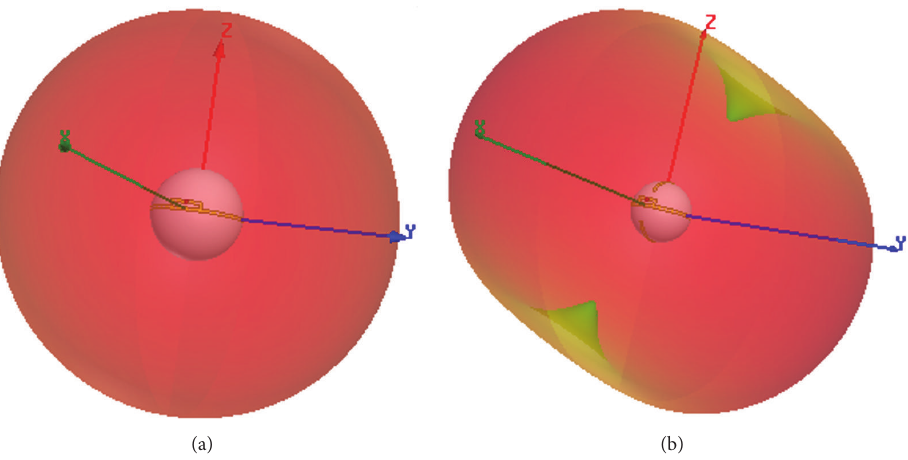
Figure 17: Radiation patterns ( 𝐸 total ) in 3D of the 3D spherical antenna (Table 6): (a) 𝑟 = 22 mm and (b) 𝑟 = 14 mm.